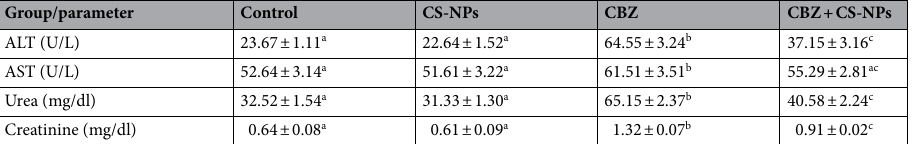
Table 3. The effect of carbendazim (CBZ) and/or chitosan nanoparticles (CS-NPs) on some liver and kidney biomarkers. All data are presented as mean ± SEM (n = 5 rats/ group). Values bearing different superscripts (a, b, c) at the same row means significant at P ≤ 0.05.